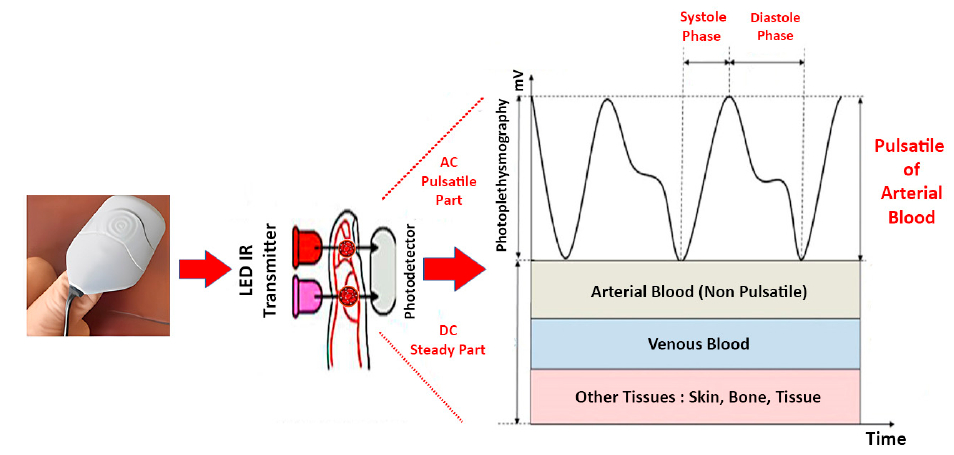
Figure 2. Dual component the PPG signal’s structure.